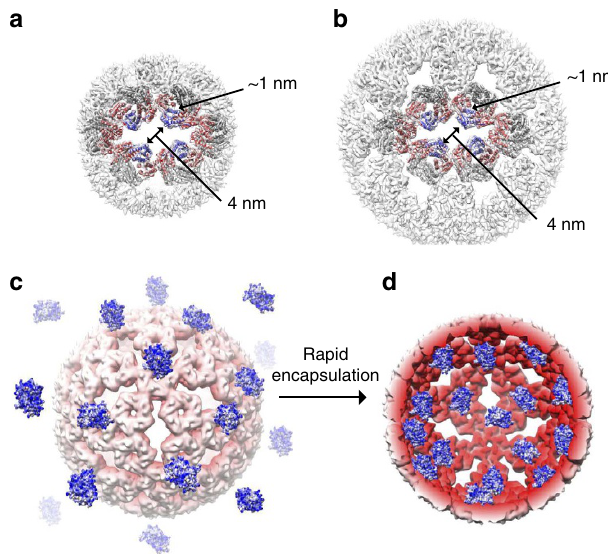
Figure 7 | Diffusion-limited protein cargo loading. ( a , b ) The keyhole- shaped openings of AaLS-neg ( a ) and AaLS-13 ( b ). Each slot is surrounded by 16 protomers, 4 of which (shown in blue) lack the inter-pentamer interactions. ( c , d ) Scheme illustrating spontaneous encapsulation of supercharged GFP molecules by AaLS-13. A half-sliced AaLS-13 cage is depicted ( d ) to show association of the guest with the cage interior.